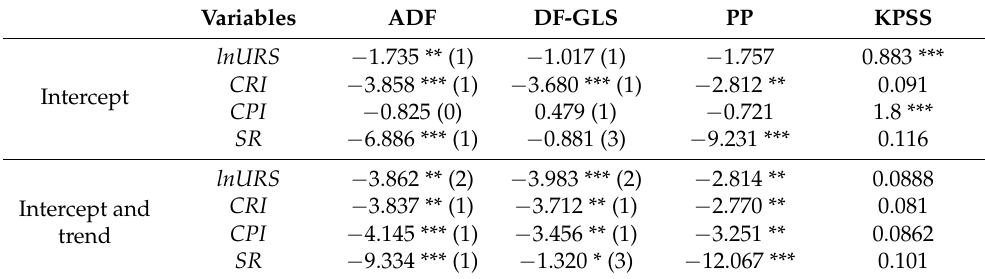
Table 2. Unit root test results.